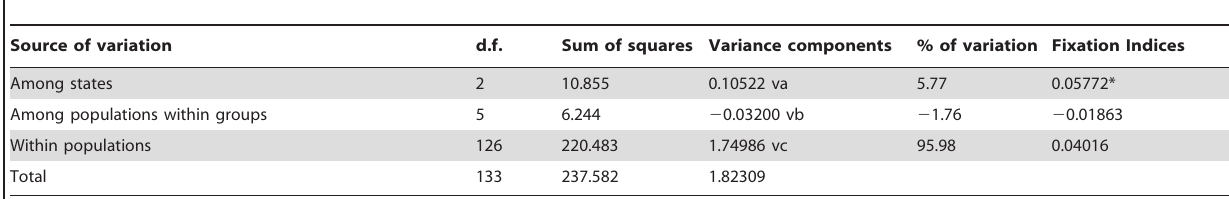
Table 6. AMOVA table describing relationships among populations and within populations of L. hesperus Knight (p-values for va, vb and vc are: 0.02053, 0.67937, 0.09384. *P , 0.05, **P , 0.01).